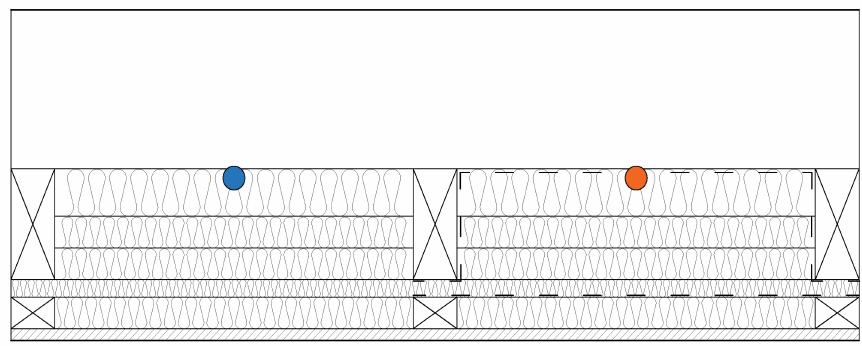
Figure 7. Sensors Layout in the Walls LW1 (orange, right) and LW2 (blue,